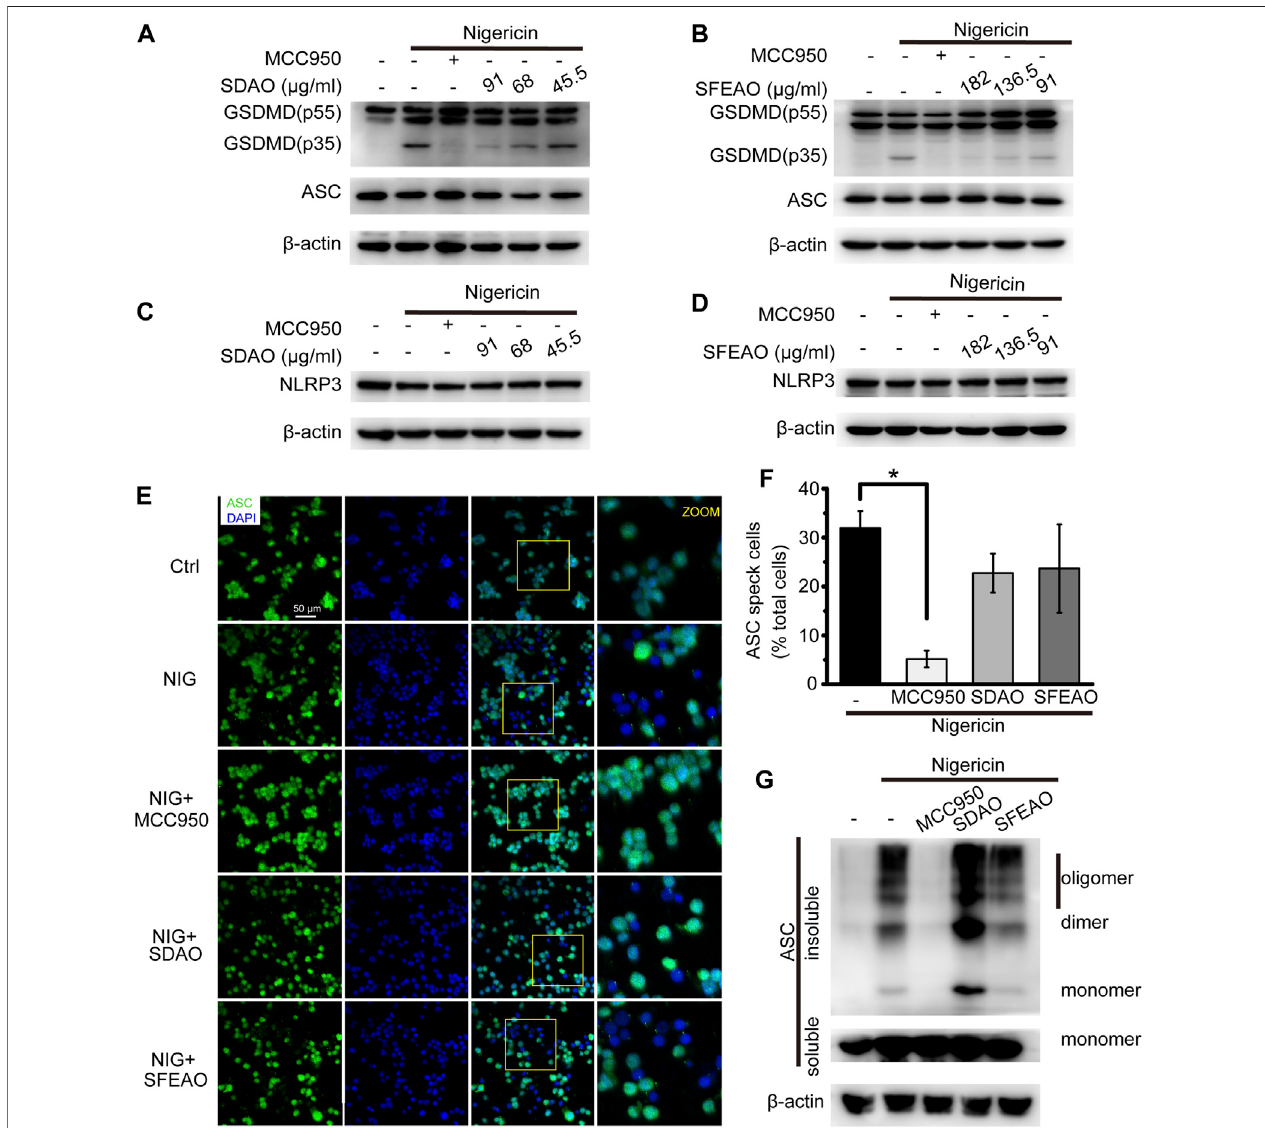
FIGURE8| EOAAinhibitsGSDMDslicingandhasnoeffectonNLRP3expressionandtheformationofASColigomersafternigericintreatment.PMA-primedTHP- 1 cells were treated with or without MCC950 (20 μ M) or different concentrations of SDAO or SFEAO and stimulated with nigericin (10 μ M) for 1 h. The levels of cleaved GSDMD (A , B) and NLRP3 in whole-cell extracts were measured by immunoblotting (C , D) . β -Actin was used as an internal control. PMA-primed THP-1 cells were treated with or without MCC950 (20 µM), SDAO (91 µg/ml) or SFEAO (182 µg/ml) upon stimulation with nigericin (10 µM) for 1 h. (E) Cells stained with anti-ASC antibodytodetectASCspecks(green)andwithDAPItodetectnuclei(blue). (F) ThepercentageofcellswithASCspecksamongallcellsispresented. (G) ASColigomers wereextractedfromtheTritonX-100insolublepartofthecellextractbyDSScrosslinkingandmeasuredbyimmunoblotting.NIG:nigericin.ASCspeckwasquanti fi edby thecellswithASCspecksrelativetothetotalcellsfromthreeindividual fi eldsineachexperiment.Datawerefromthreeindependentexperiments( F ;meanandSEMof n (cid:2) 3) or representative of at least three independent experiments (A – G) . Arcsine-square root transformation of the percent data was used for statistical analysis. Statistics were analyzed using one-way ANOVA by Bonferroni post hoc test, * p < 0.05, ** p < 0.01, *** p < 0.001.